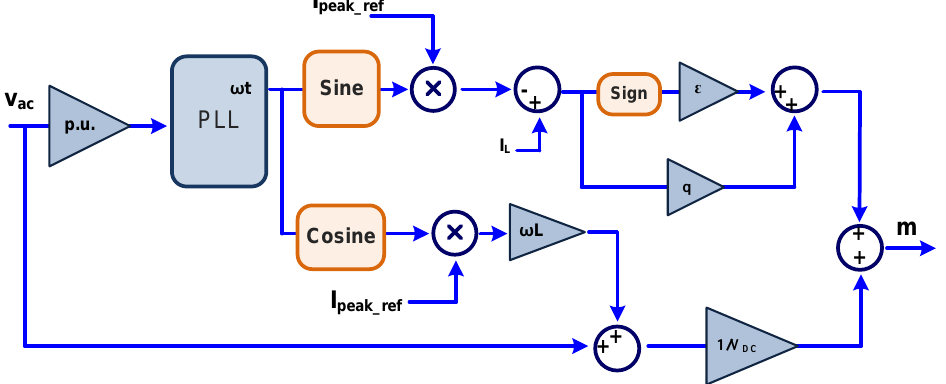
Figure 6. SMC control diagram strategy for the single-phase VSI with the L filter.